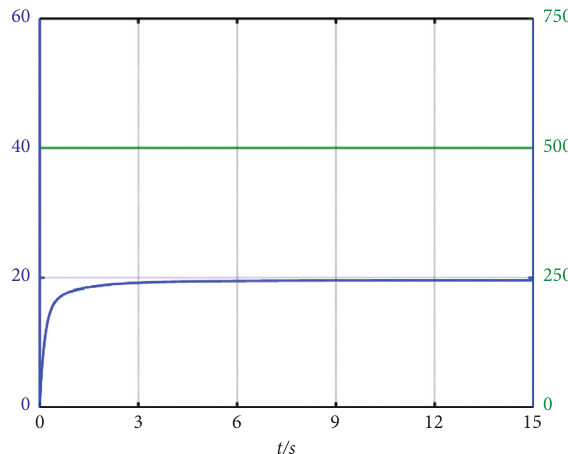
Figure 13: Trajectories of practical energy consumption and total energy supply for the leader-following case.